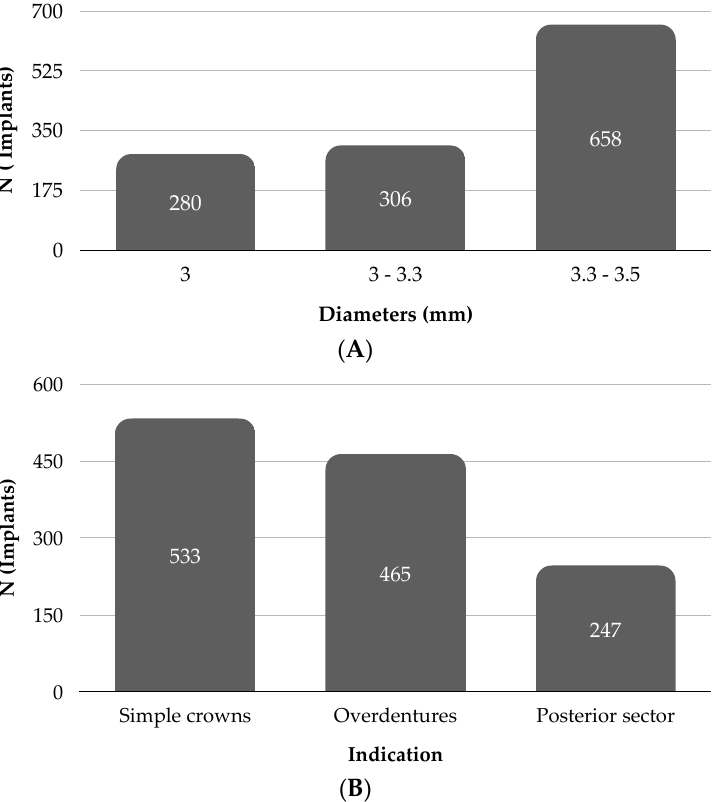
Figure 2. ( A ) Classification of implants according to diameter. ( B ) Classification of implants according to the indication.